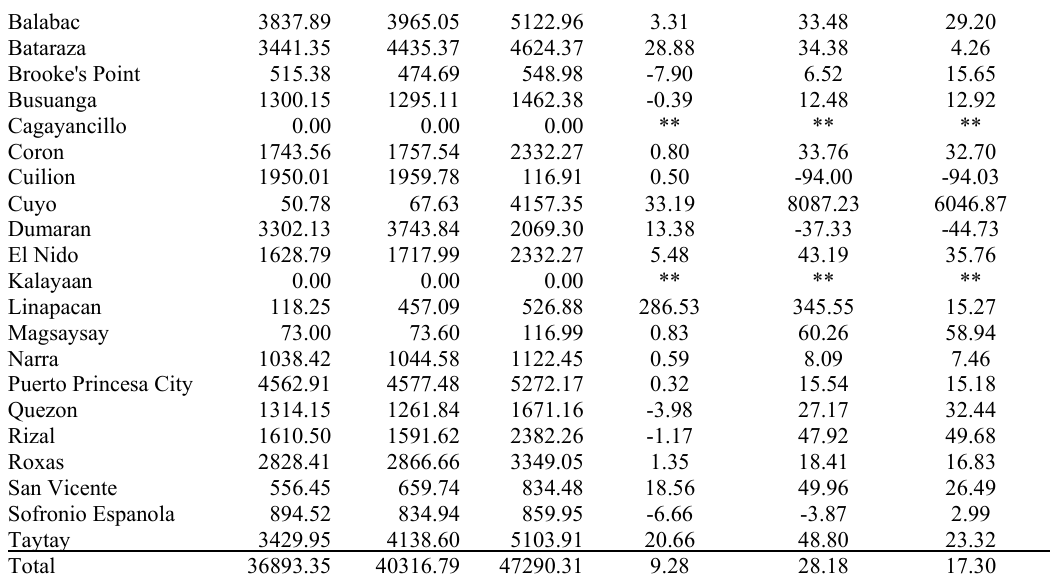
Table 5. Extracted Mangrove area (in ha) estimates in Palawan. Note: *percent change from 0 to a value. **percent change from 0 to 0.